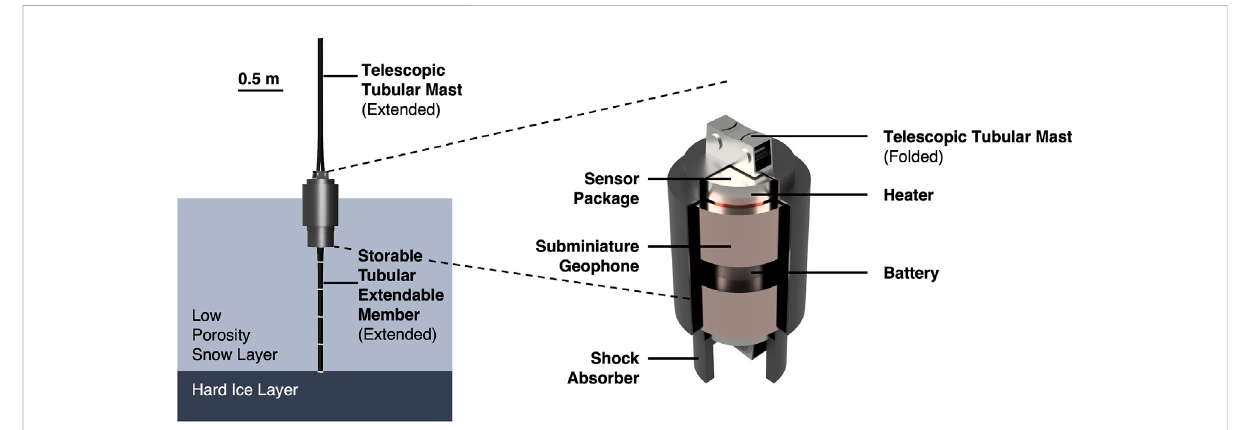
FIGURE 7 Artist ’ srenditionoftheSHOOCsystem. TheschematicillustratesaSHOOC probeembeddedonthesurfaceofEnceladus,withbothtelescopic components deployed. A zoom-in shows the Interior cross-section diagram of a probe. For scale, tubular masts are 1.5 m